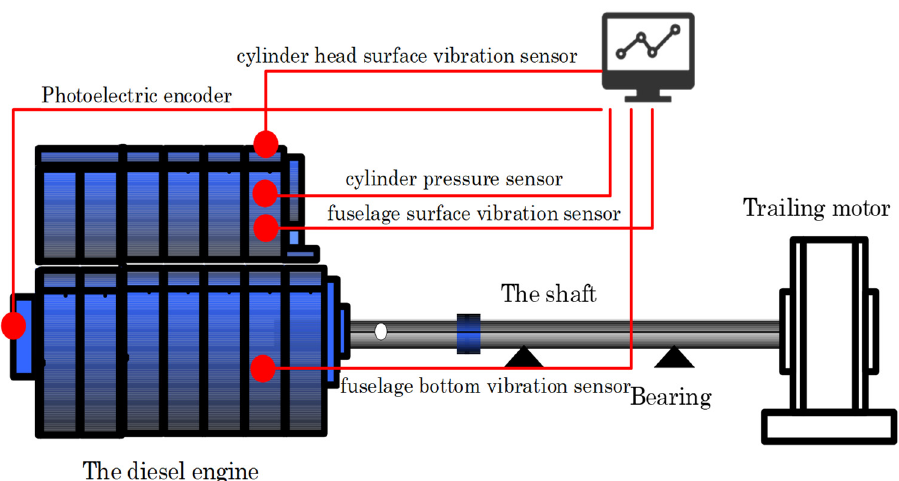
Figure 2. The schematic